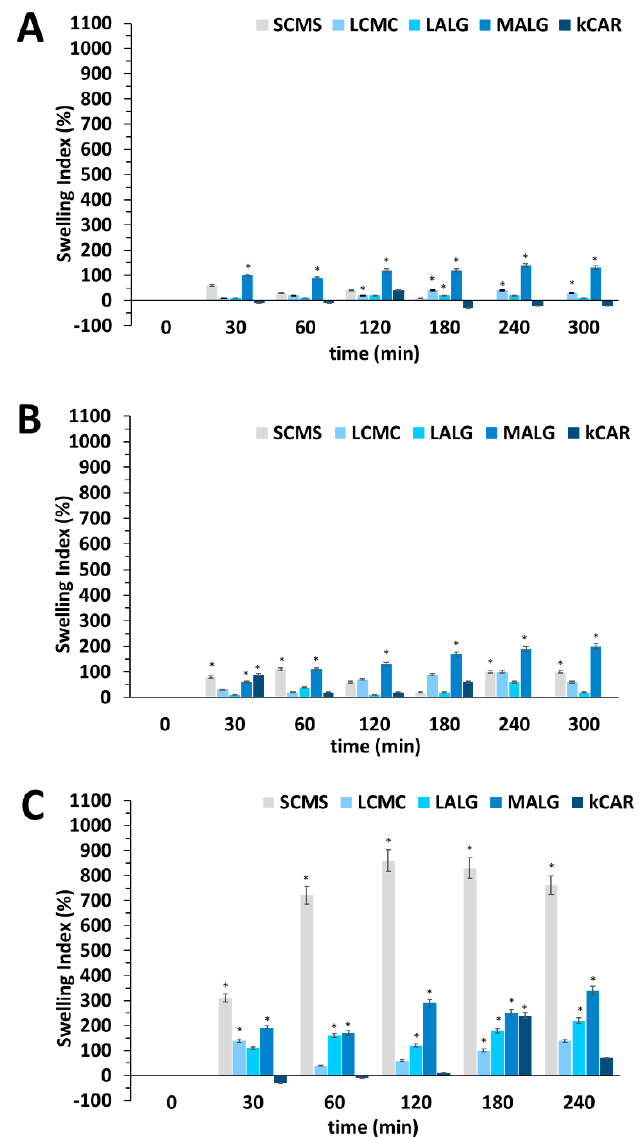
Figure 2. Comparison of the swelling indices of the CE-loaded polysaccharide microparticles in media at pH = 2 ( A ), pH = 7 ( B ), and pH = 10 ( C ). The results are presented as the means ± S.D. * The difference was statistically significant at p ≤ 0.05.